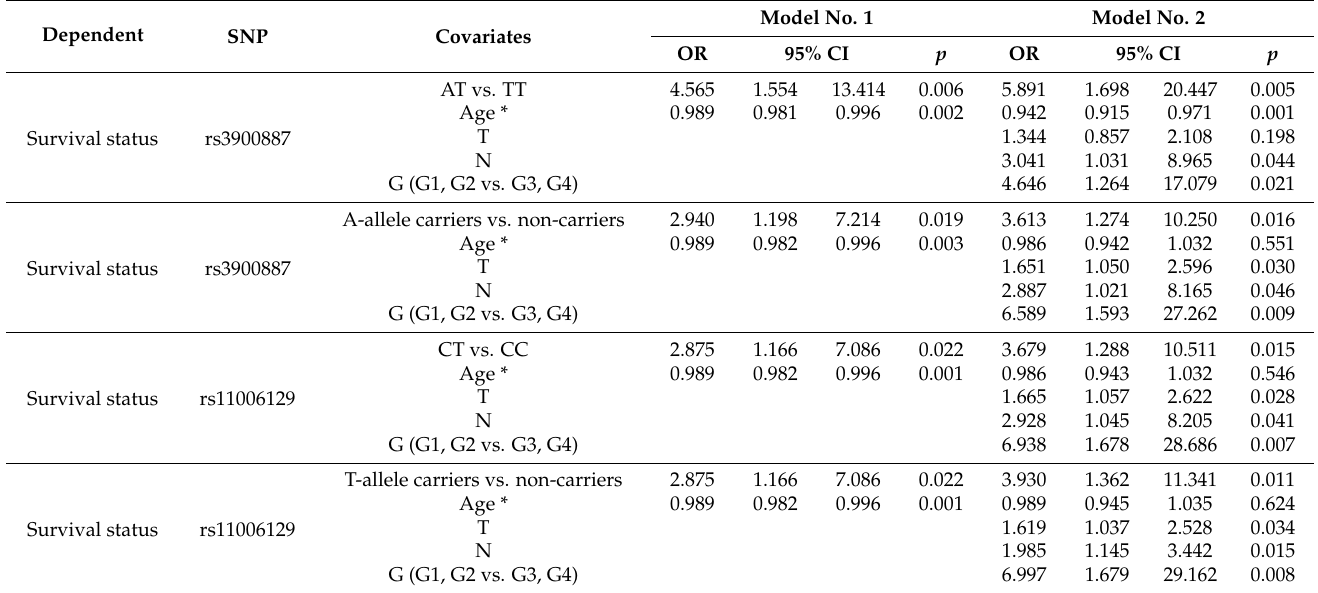
Table 6. Univariate and multivariate logistic regression analyses between TFAM rs3900887 and rs11006129 and fact of